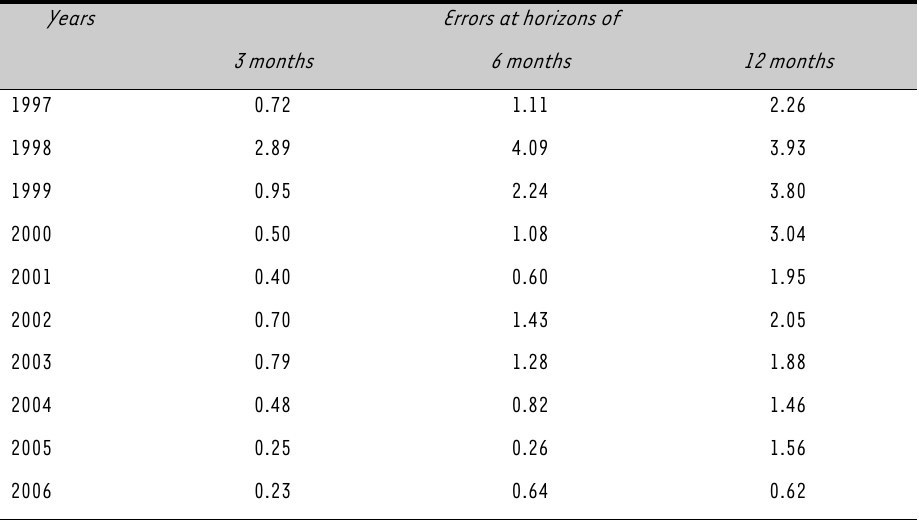
TABLE 2: Time Series for Absolute forecast Error in JIBAR (annual averages, in basis points) Years Errors at horizons